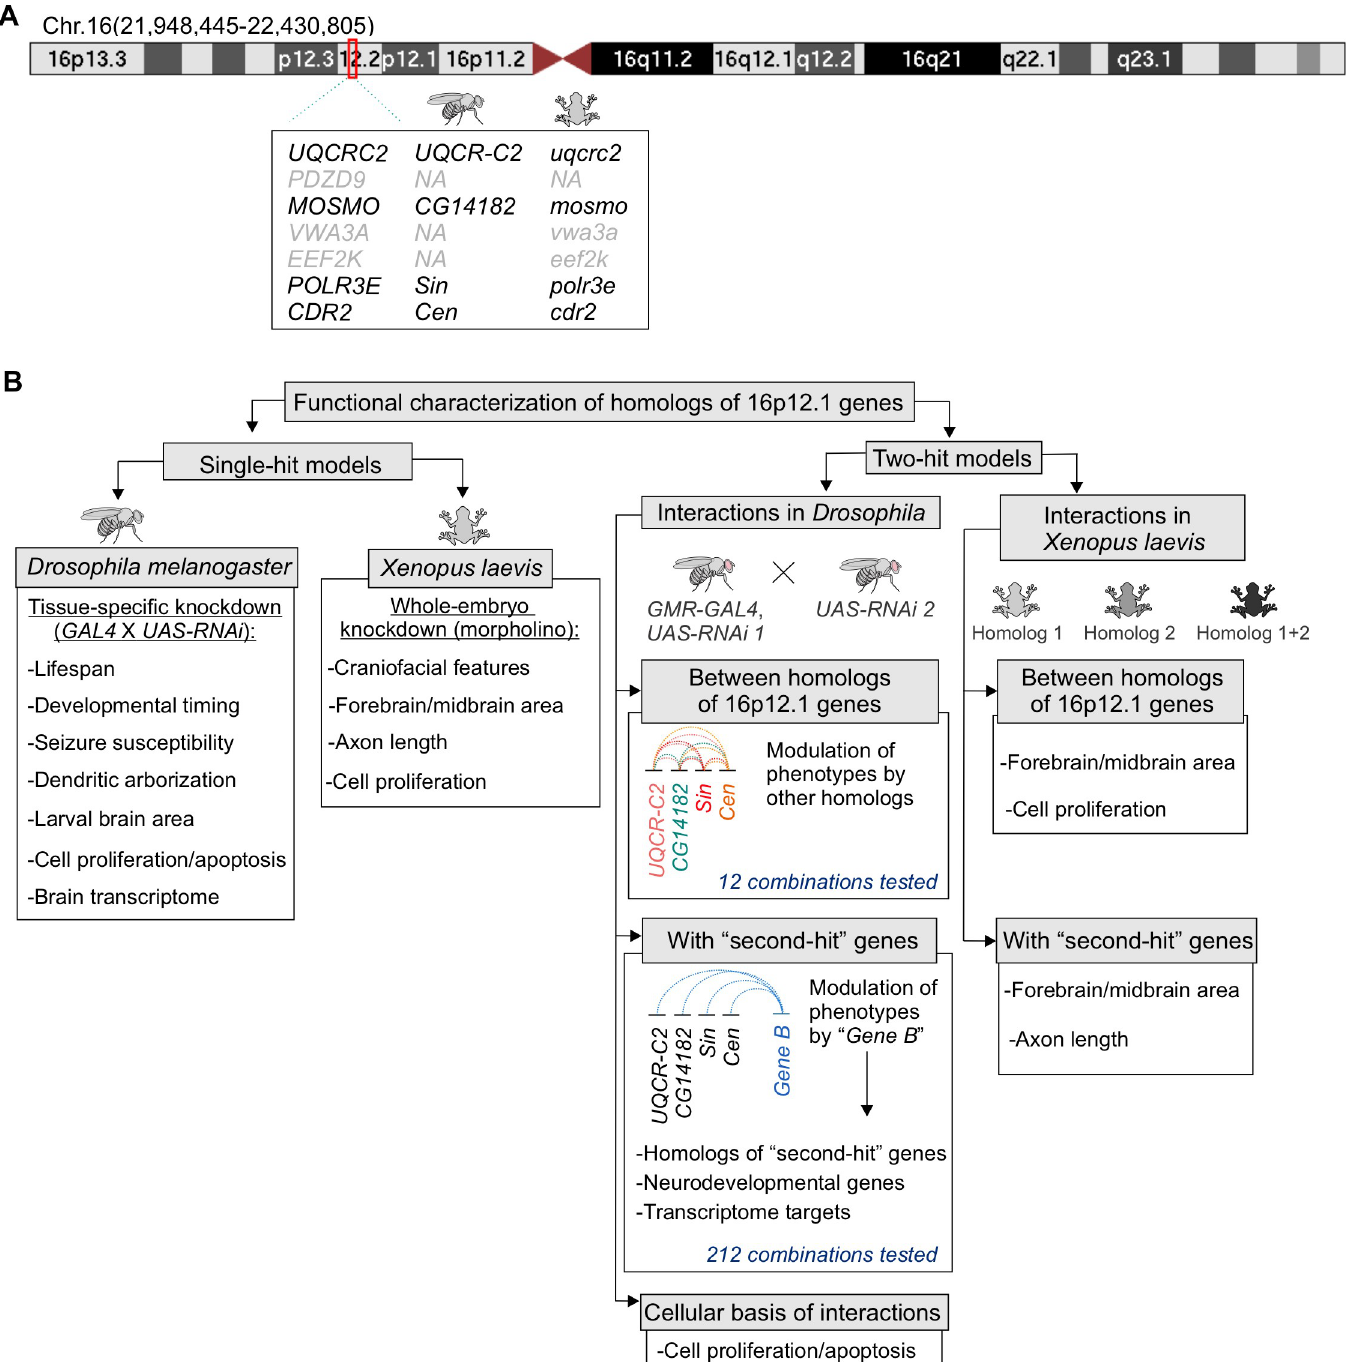
Fig 1. Strategy to evaluate the individual contributions of homologs of 16p12.1 genes and their interactions with “second-hit” genes towards neurodevelopmental phenotypes. (A) Ideogram of human chromosome 16 indicating the deleted region on UCSC genome build GRCh37, hg19 (chr16:21,948,445–22,430,805) (also known as 16p12.2 deletion). Seven protein coding genes are located within the 16p12.1 deletion region, including UQCRC2 , PDZD9 , MOSMO , VWA3A , EEF2K , POLR3E , and CDR2 . Four out of the seven genes are conserved in both Drosophila melanogaster and Xenopus laevis . (B) We performed global and functional domain-specific phenotypic assessment using RNAi lines and tissue-specific knockdown in Drosophila , and morpholino-mediated whole embryo knockdown in X . laevis , to identify individual contributions of 16p12.1 homologs towards different developmental and neuronal features. We next evaluated the effect of pairwise knockdown of 16p12.1 homologs towards eye phenotypes in Drosophila , and brain size and cellular proliferation defects in X . laevis . We characterized 212 interactions between the 16p12.1 homologs and homologs of patient-specific “second-hit” genes identified in children with the deletion, genes within conserved neurodevelopmental pathways, and differentially-expressed genes identified from RNA-seq analysis. We found that homologs of “second-hit” genes participate in complex genetic interactions with 16p12.1 homologs to modulate neurodevelopmental and cellular phenotypes.